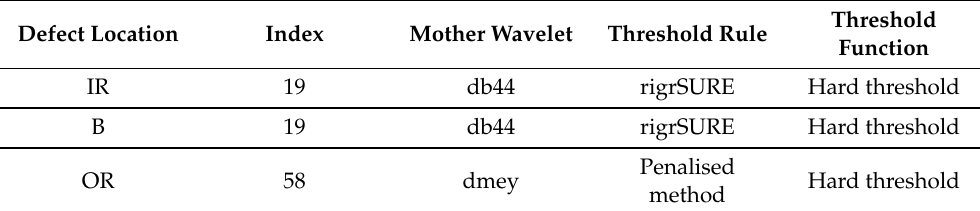
Figure 6. Comparison of TO values for defects of size 0.014 in. Table 2. Parameters required to maximise the TO value for rolling bearings’ signals with localised defects with varying locations, but the same diameter, equal to 0.014